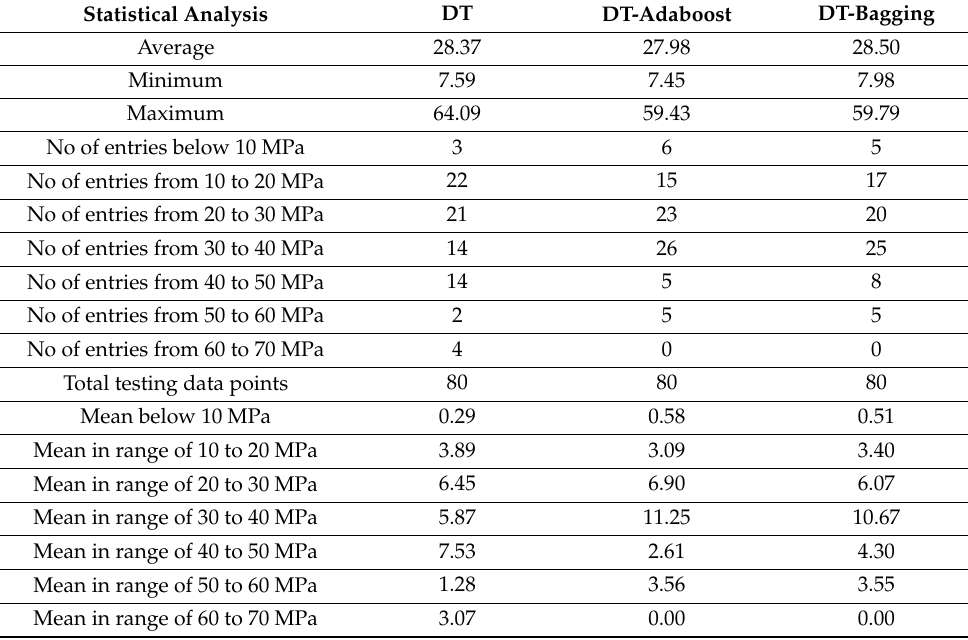
Table 9. Statistical analysis of compressive strength decision tree model.